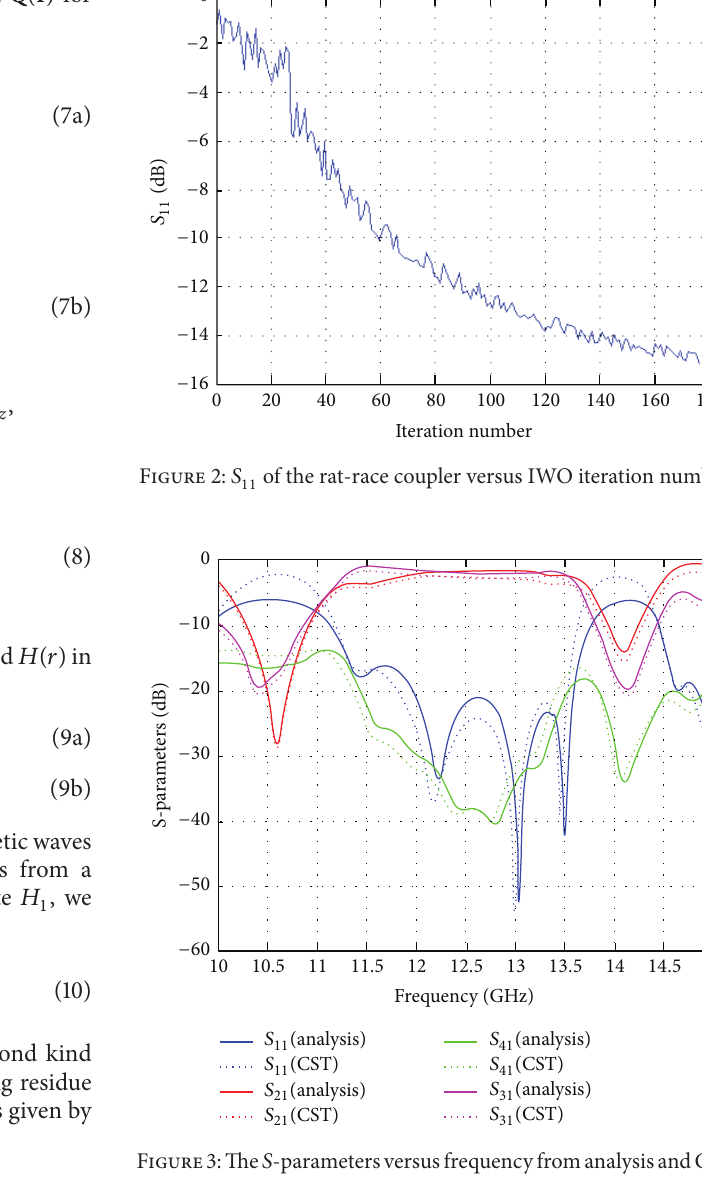
and vice versa. The 𝑚 and 𝑛 in (11) are eigenvalues modes in vertical and azimuthal directions,